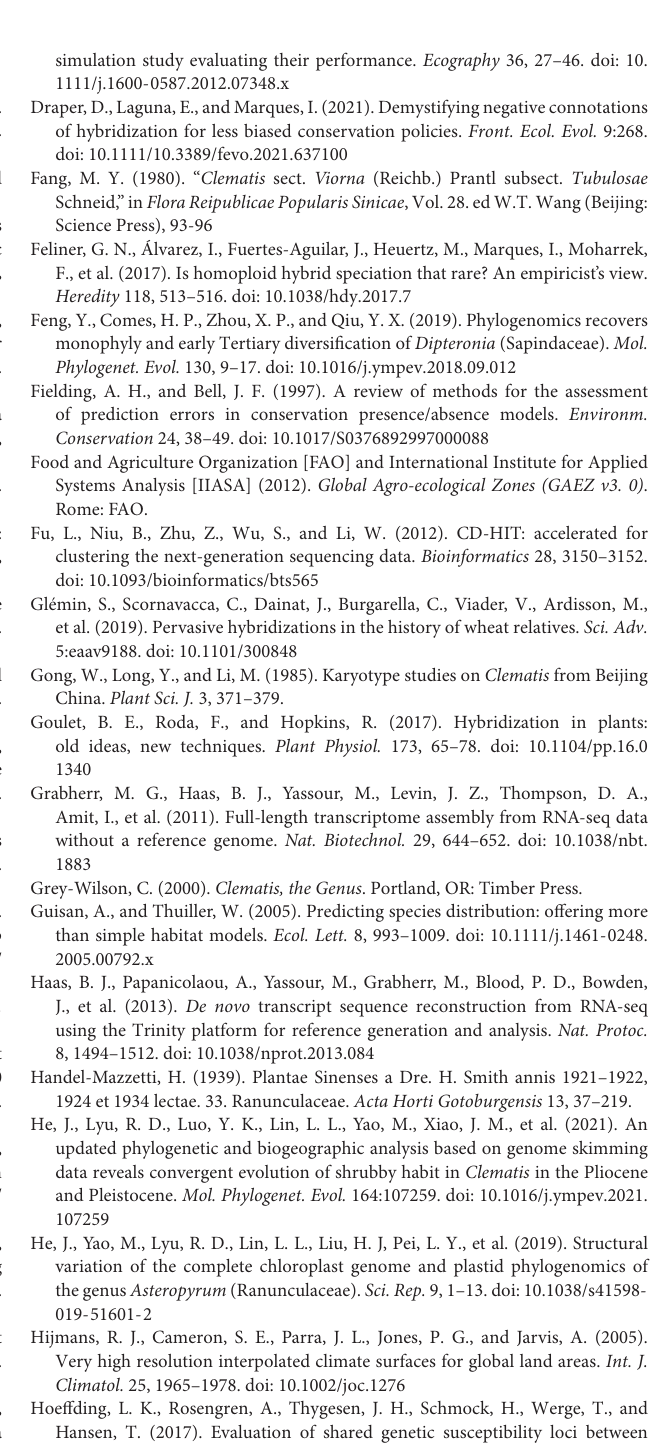
Supplementary Table S6 | The 33 environmental variables used for the niche modeling. Supplementary Table S7 | Flow cytometry analysis of Clematis tubulosa and C. pinnata using C. brevicaudata as an external standard reference. Supplementary Table S8 | Flow cytometry analysis of Clematis heracleifolia using C. brevicaudata as an external standard reference.